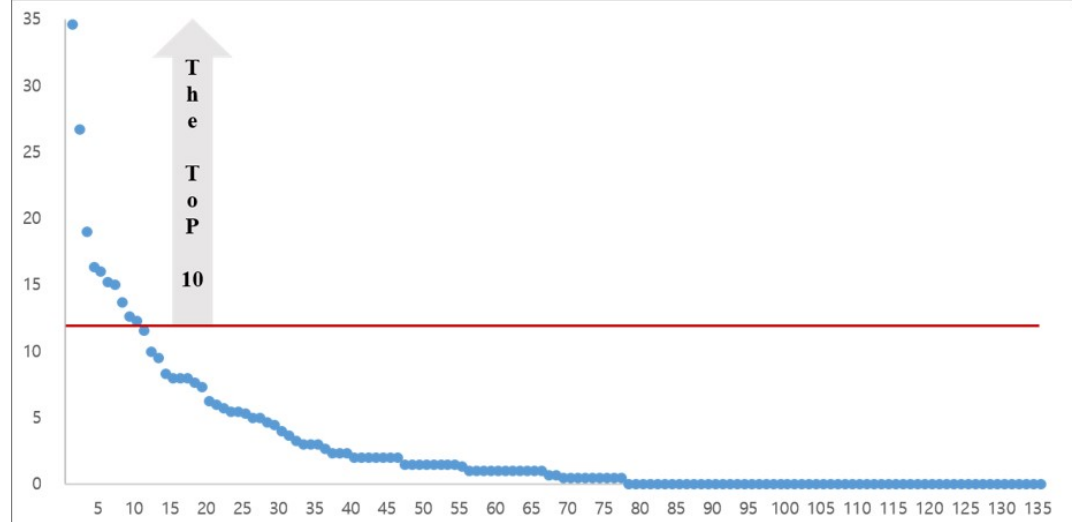
Figure 7. Distribution of the articles by the annual average numbers of citations (note: The blue dots indicate each of the 135 articles; X -axis shows the rank of the 135 articles by the annual average numbers of citations; Y -axis indicates their annual average numbers of citations; The blue dots above the red line are the top ten articles ranked by their annual average numbers of citations).